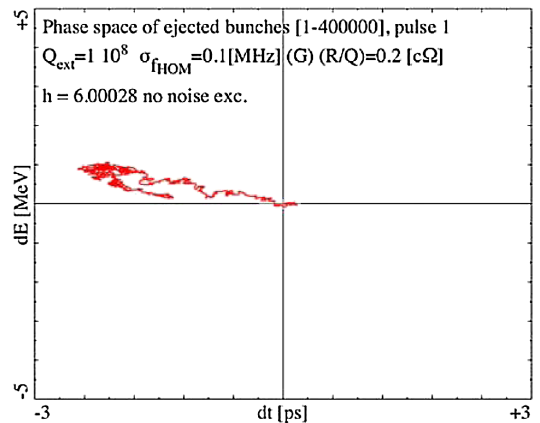
FIG. 43. (Color) Phase-space image of the ejected bunches of the second pulse. Conditions as Fig. 38 ( Q ext ¼ 10 8 ) but ð R=Q Þ ¼ 1 (cid:2) .